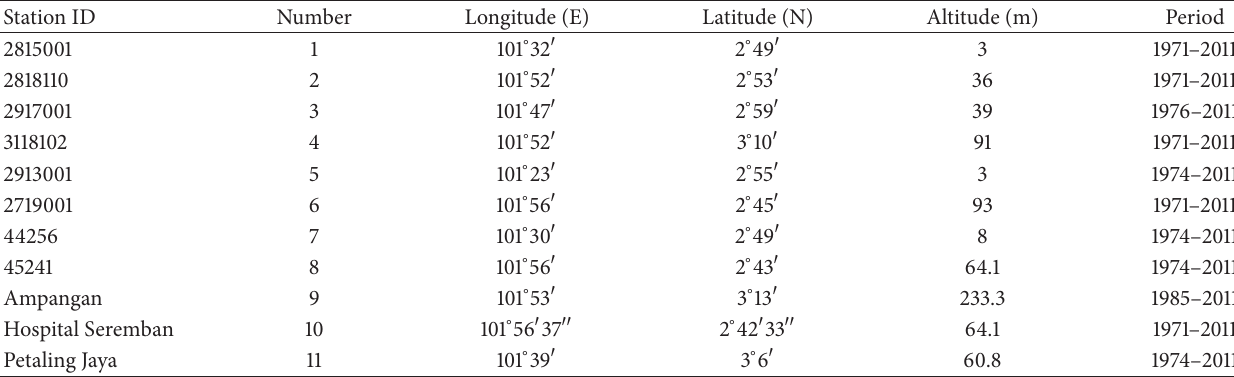
Table 1: Geographic characteristics of stations for recorded precipitation